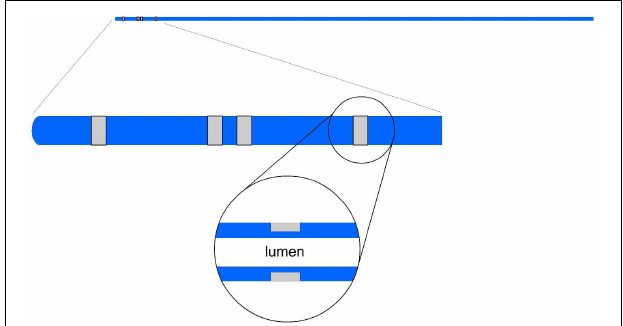
FIGURE 1 | An illustration of an impedance catheter where the four electrodes are spaced at the tip (two inner and two outer electrodes) in the top panel; a zoom of the embedded portion of the electrode arrangement is shown in the middle panel; and a further zoom of the wire tunneling is shown in the lower